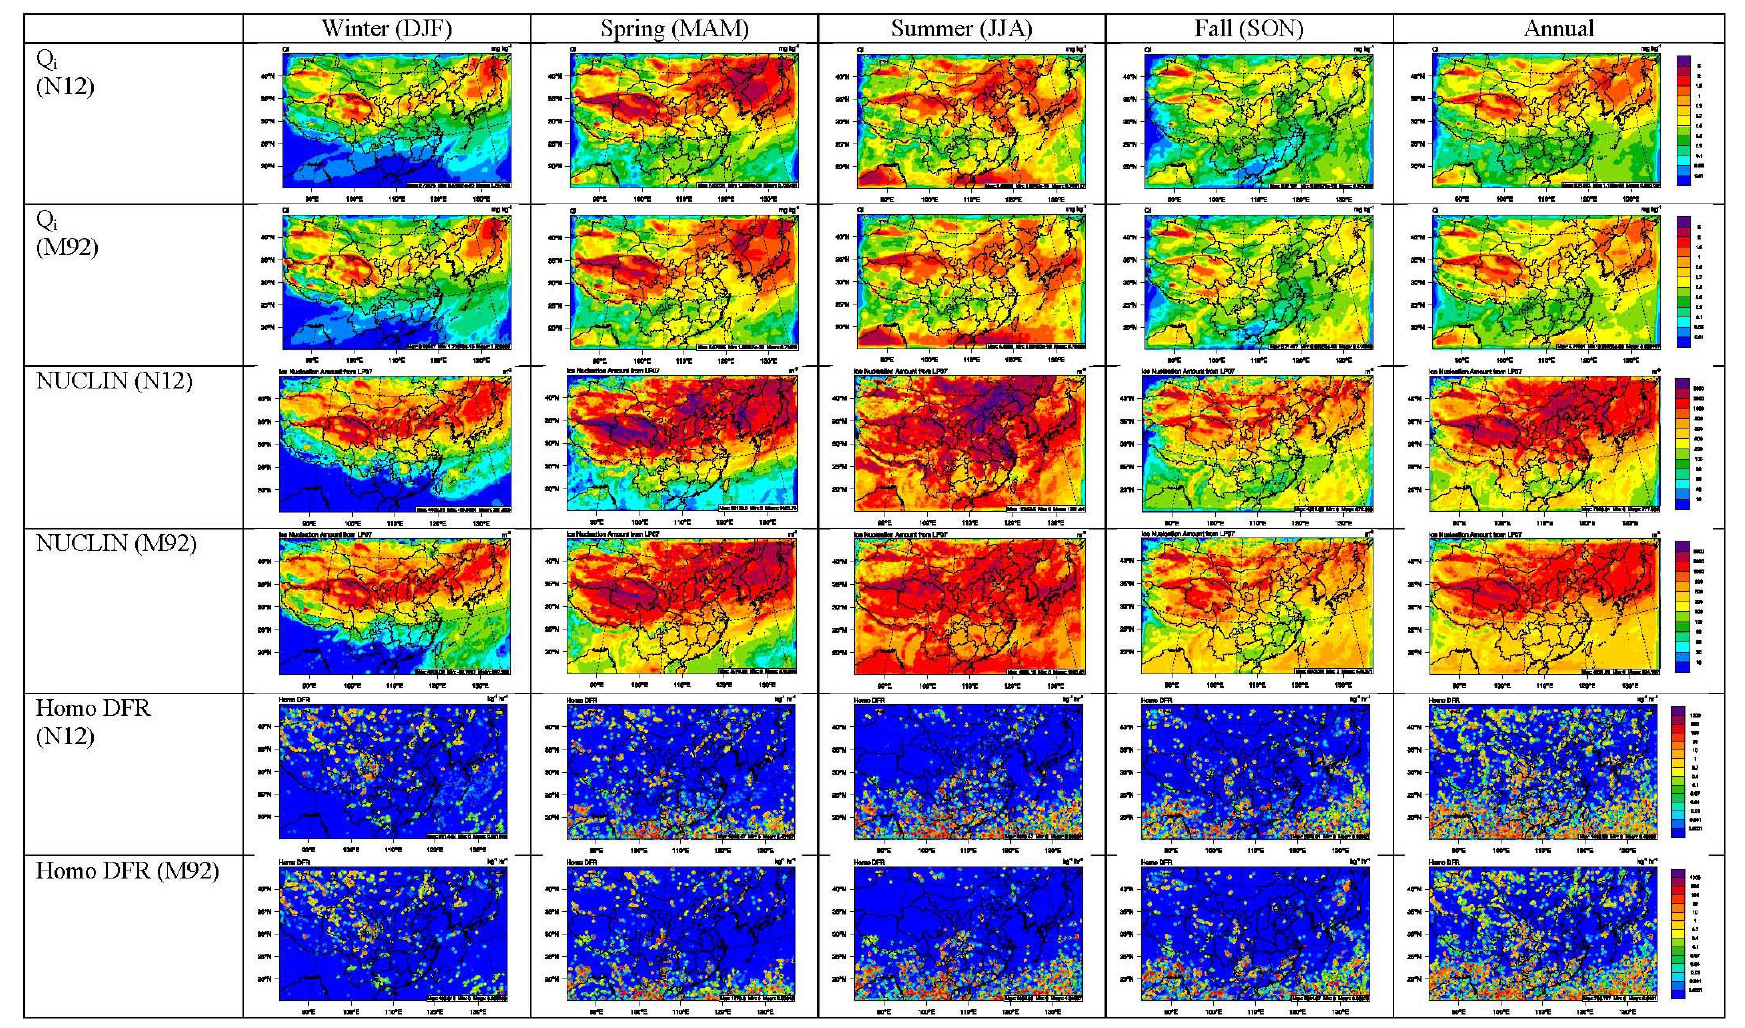
Figure 3. Spatial distributions of average values of Q i , NUCLIN, and Homo DFR over all model layers between simulations in 2006 with N12 and